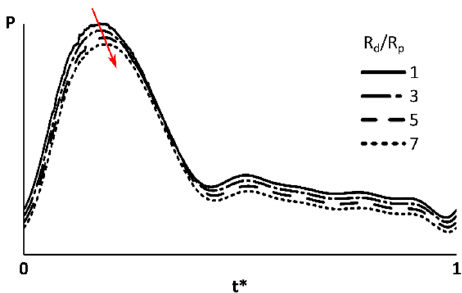
Figure 4. Flow rate Q avg [ Q min , Q max ] in tumor outlets for two simulation cases with ( a ) fixed R tot and varying R d / R p and ( b ) fixed R d / R p and varying R tot .